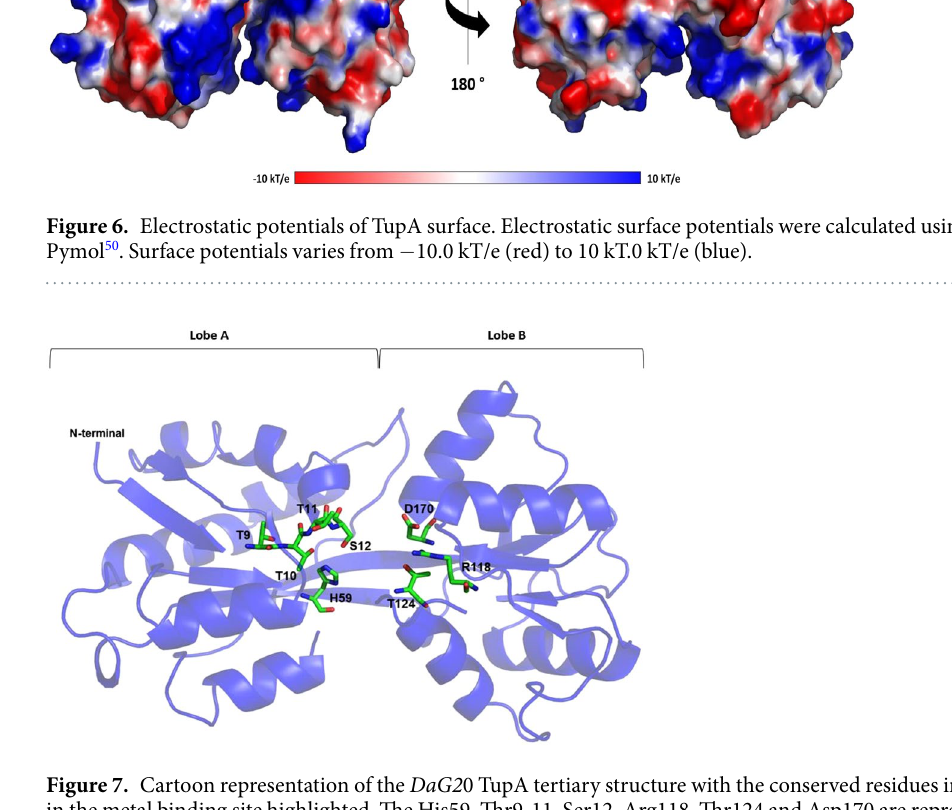
Figure 7. Cartoon representation of the DaG2 0 TupA tertiary structure with the conserved residues involved in the metal binding site highlighted. The His59, Thr9-11, Ser12, Arg118, Thr124 and Asp170 are represented as sticks and color by element. Picture prepared with Pymol 50